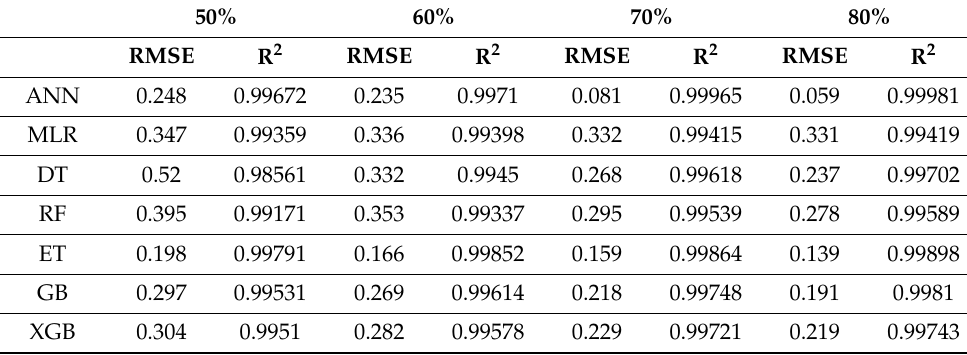
Table A2. Prediction performance based on training